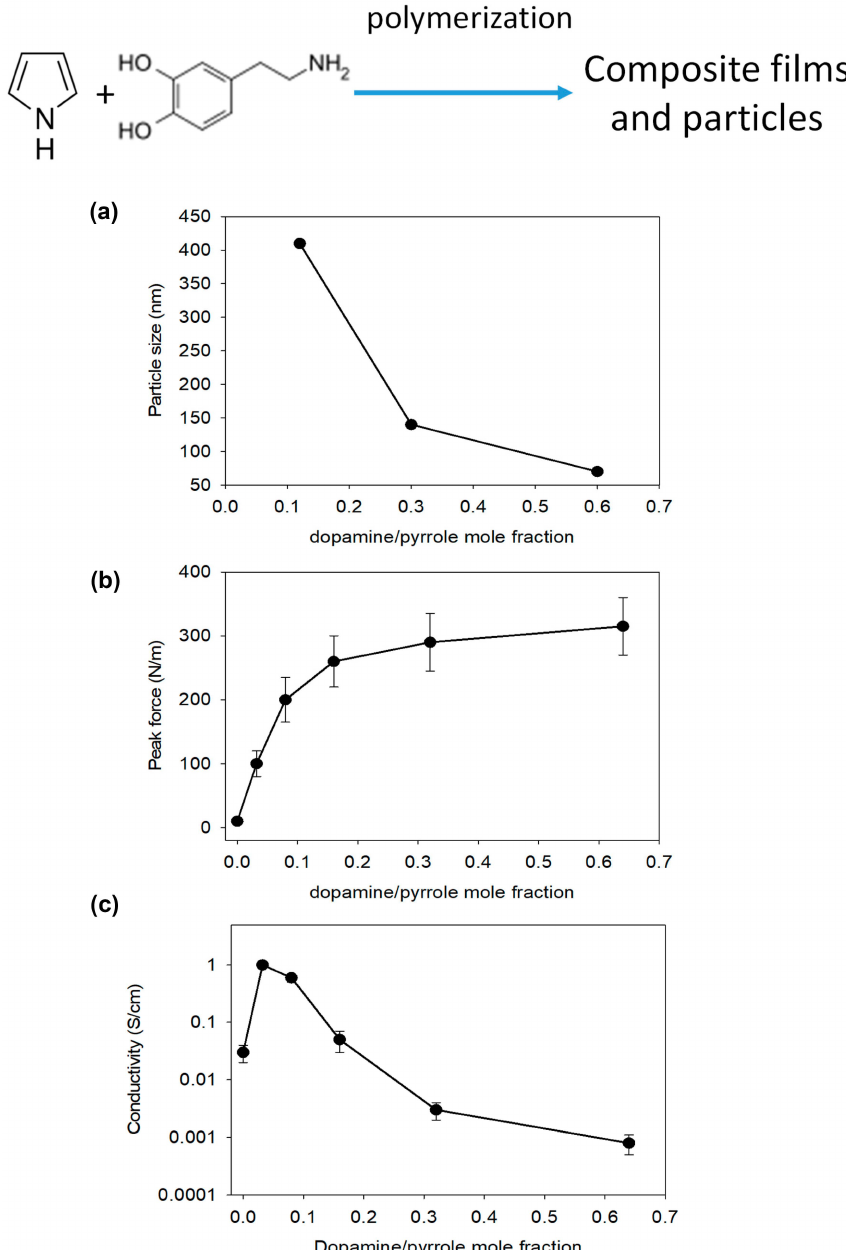
Figure 6. Influence of the presence of dopamine in pyrrole solutions on the properties of the obtained particles. ( a ) Particle size as determined by dynamic light scattering and films; ( b ) Peak force in peeling tests; ( c ) Electrical conductivity after polymerization in the presence of ammonium persulfate. Pyrrole and dopamine structures are shown at the top. Adapted with permission from